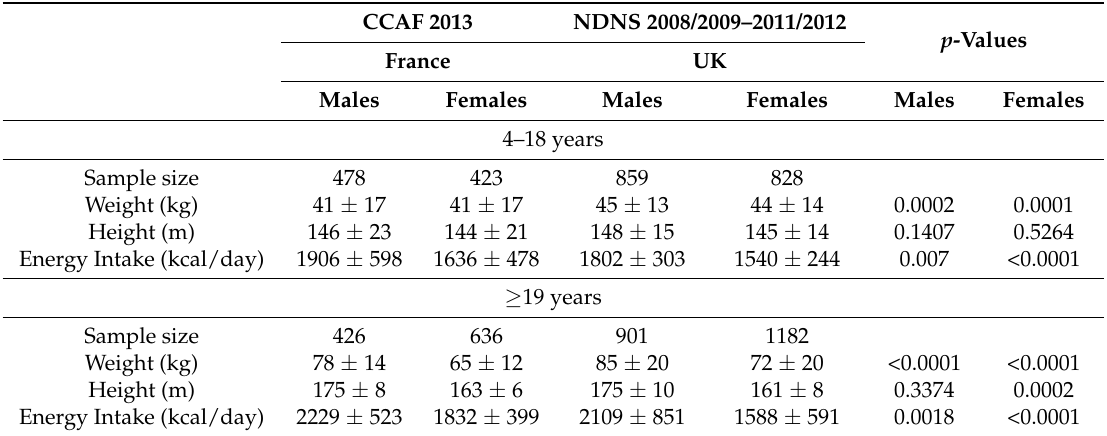
Table 2. Demographics of the both survey